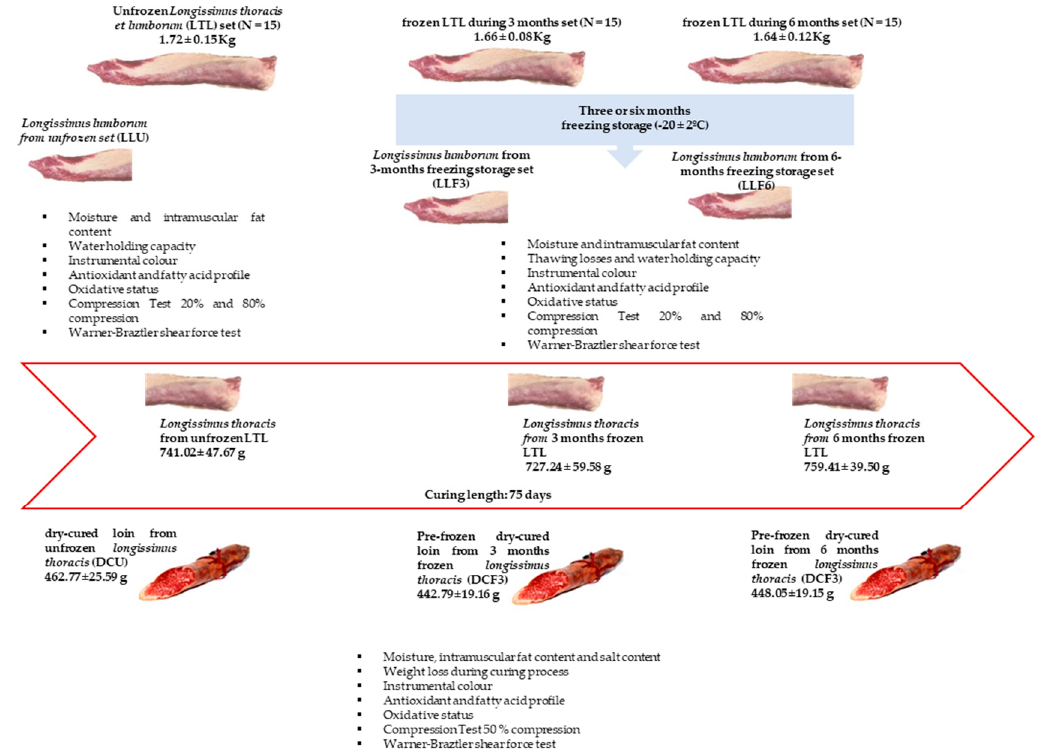
Figure 1. Experimental design.